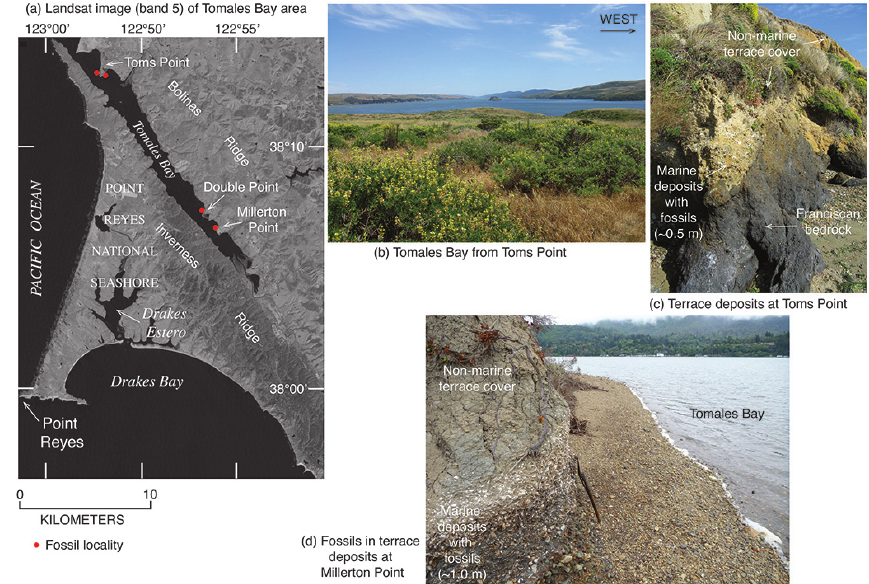
Figure 23. (a) Landsat band 5 image (from U.S. Geological Survey) of the Tomales Bay, California, area with fossil localities of the Millerton Formation (filled red circles) from Johnson (1962); the formation is correlated to MIS 5e by thermoluminescence (Grove et al., 1995) and amino acid geochronology (Muhs and Groves, 2018). (b) Ground photograph from Toms Point, looking south to Tomales Bay. (c) Marine terrace deposits with fossils exposed on wave-cut bench at Toms Point. (d) Marine deposits with fossils exposed at Millerton Point. Photographs by Daniel R.